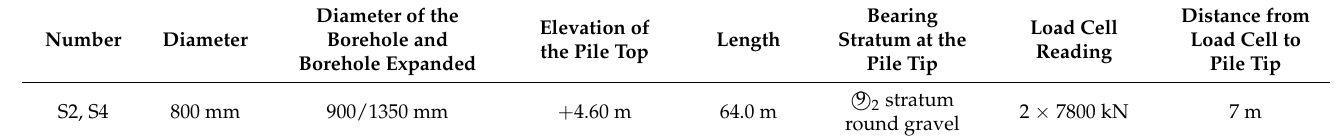
Table 1. Parameters of test piles.